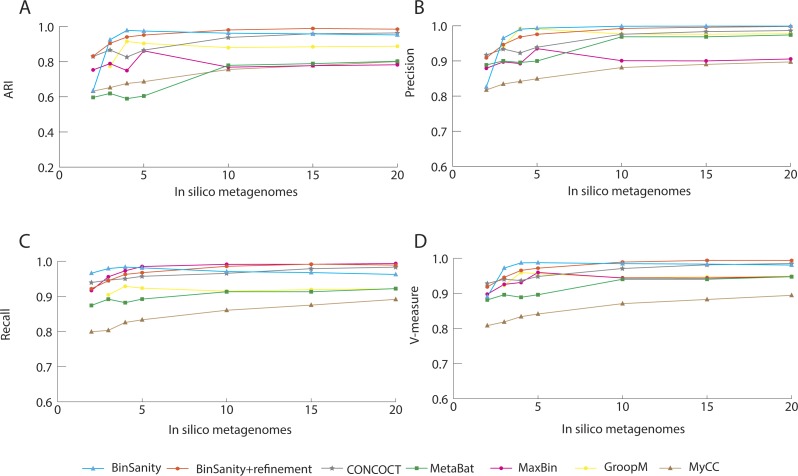
Stastistical calculations (bin_evaluation.py) showing the adjusted rand index (ARI) (A), precision (B), recall (C), and V-measure (D) for diverse-mixture-1.